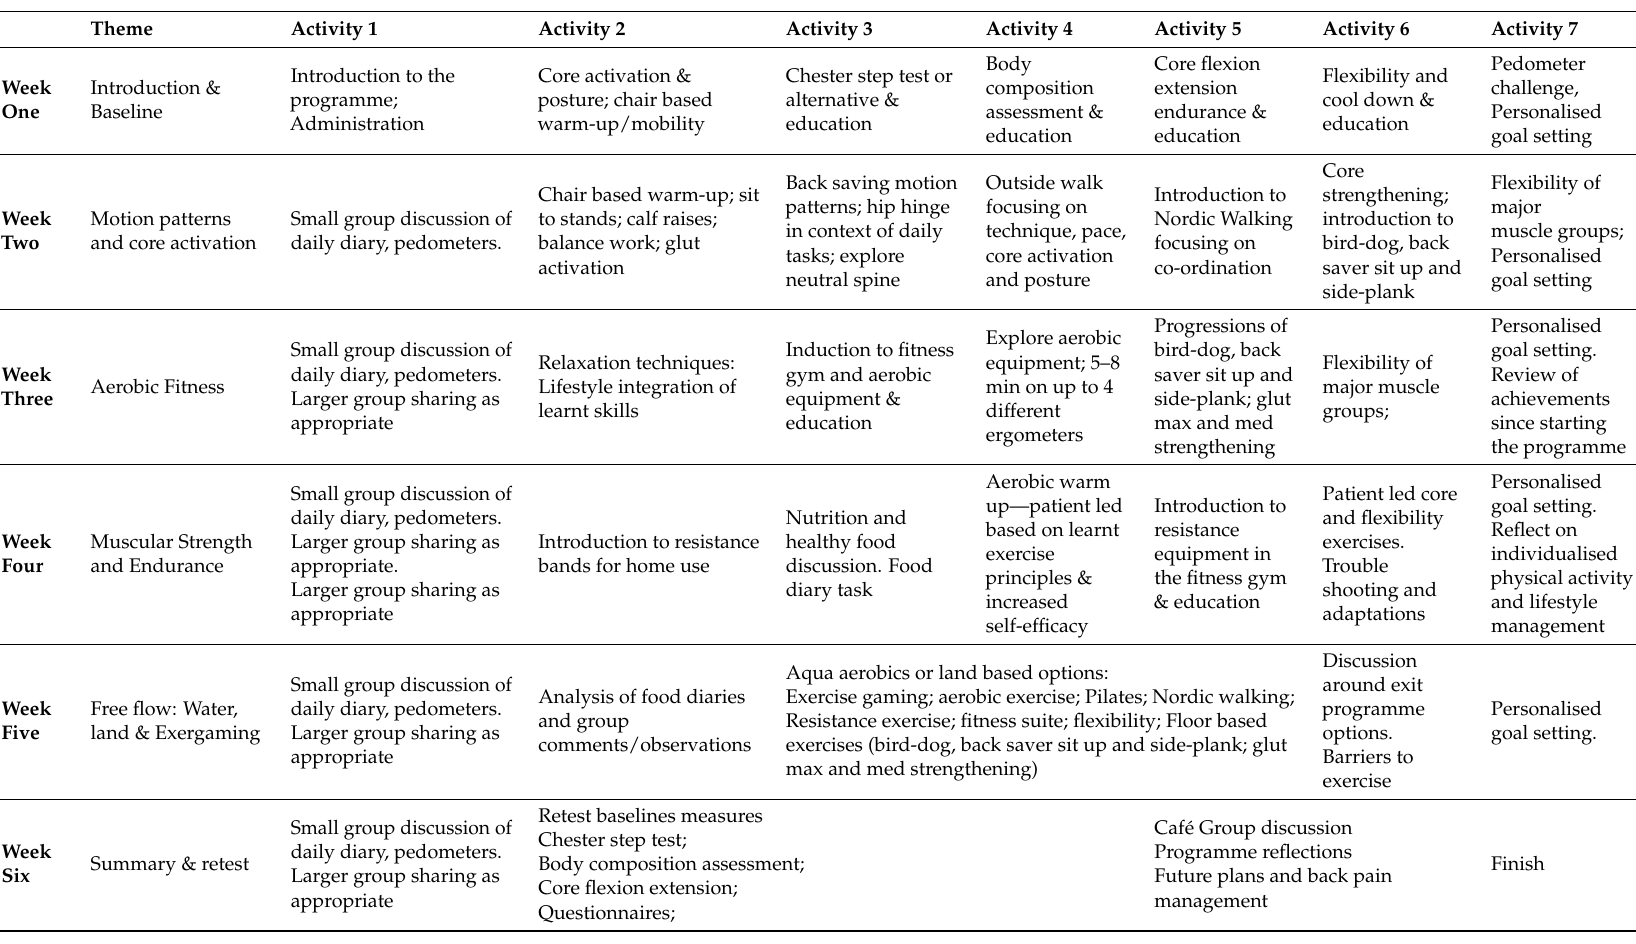
Table 1. Summary of programme